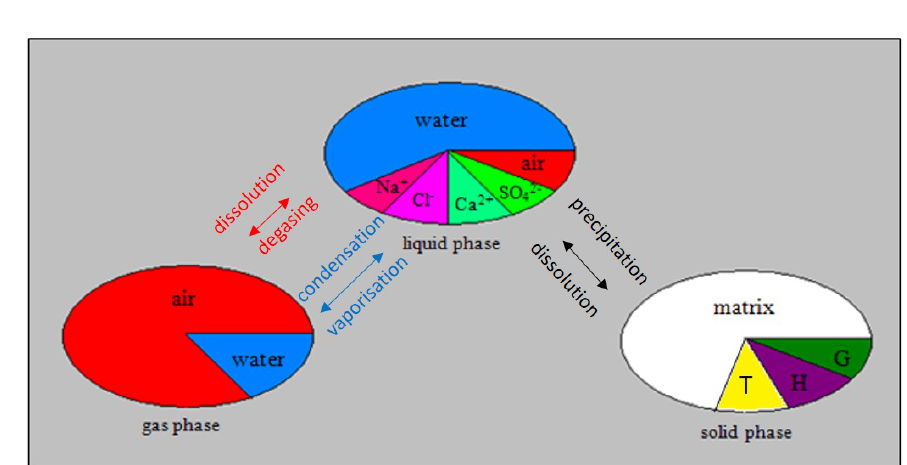
). There is exchange of 4